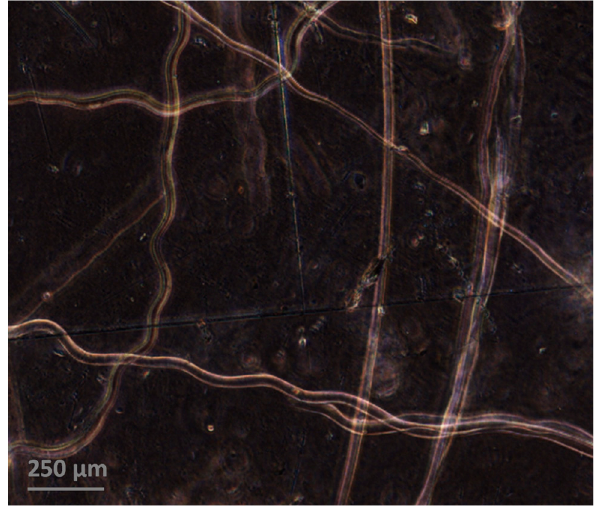
Figure 3. Morphology of e-PP/R-HAS microfibers. The microfibers were well dispersed in the e-PP matrix. The microfibers also showed a uniform diameter (25 ± 4 μ m).